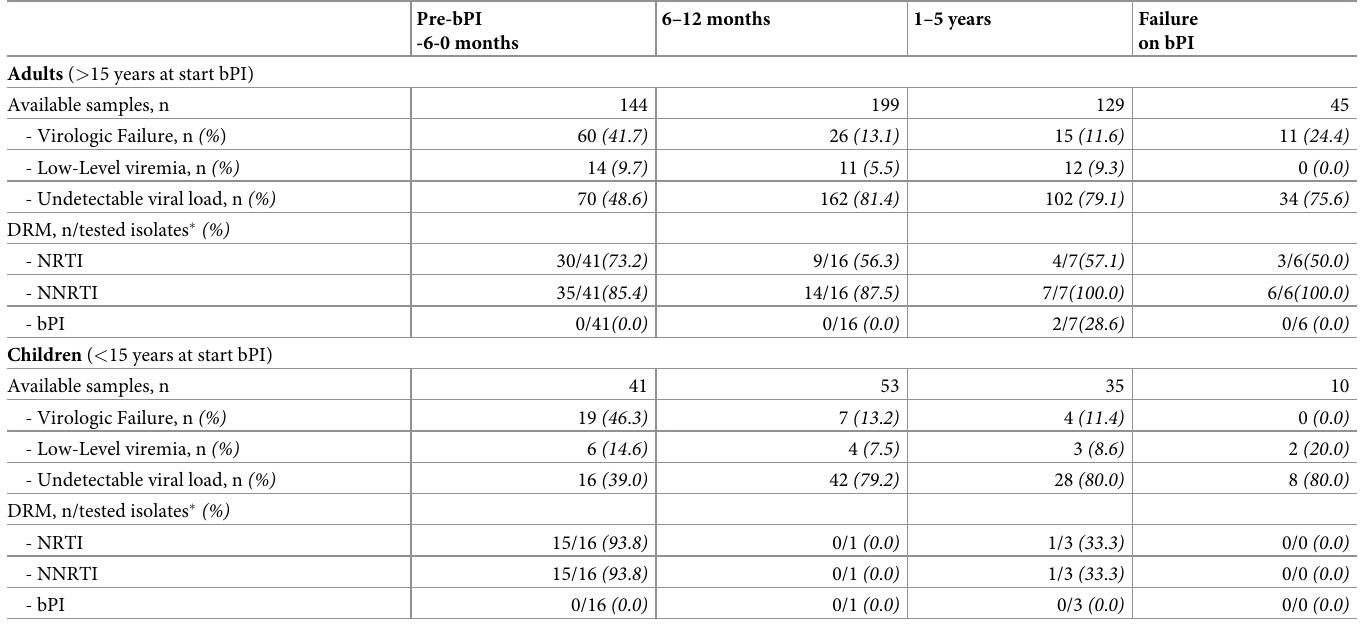
Table 2. Virologic outcome of 656 samples in 252 patients at different time